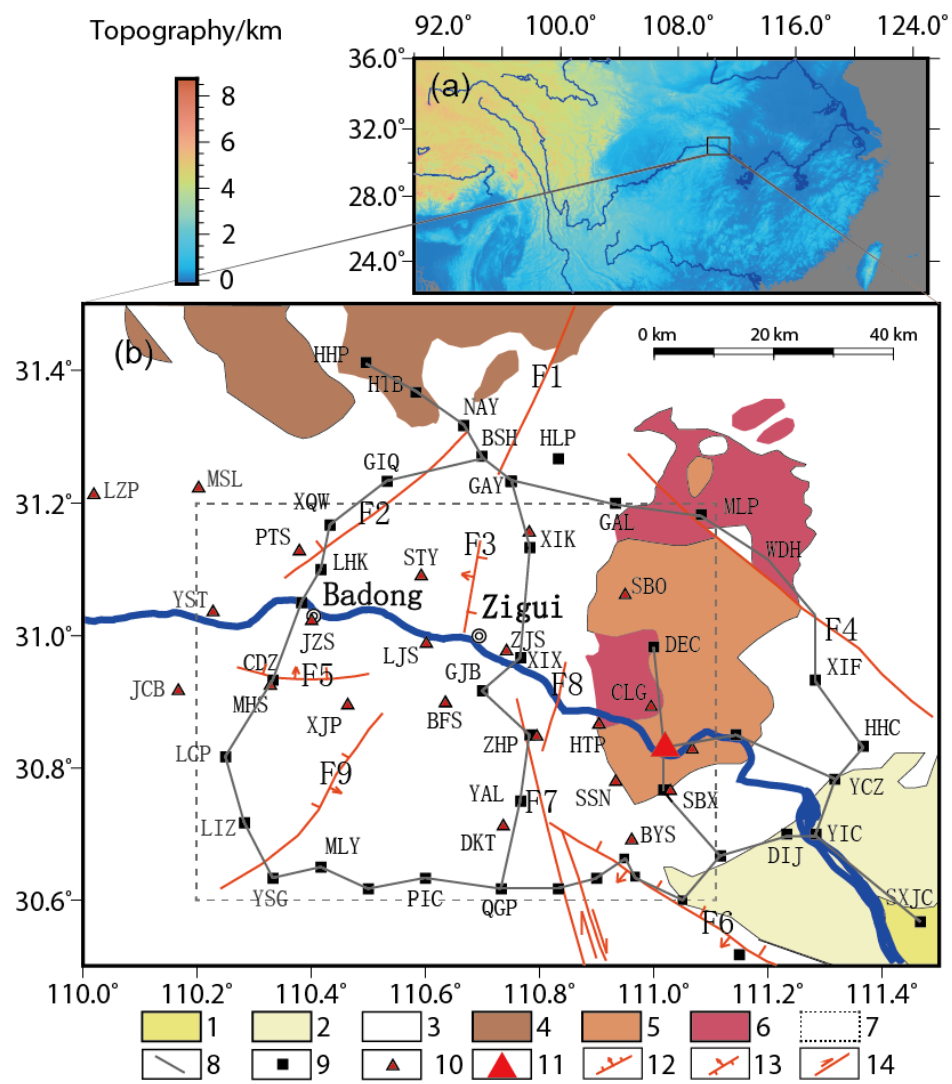
Figure 1. Comprehensive information of the head area of the TGR. ( a ) The location of the study area; ( b ) overview of the geological structure in the head area of the TGR and the reservoir-induced earth- quake monitoring system for the Yangtze River Three Gorges Project. (1. Quaternary strata; 2. Cre- taceous~Upper Triassic upper caprock structural sublayer; 3. Sinian~Middle Triassic lower caprock structural sublayer; 4. Middle Proterozoic-upper basement structural sublayer; 5. Lower Protero- zoic-lower basement structural sublayer; 6. Jingningian period intermediate-acid igneous rocks; 7. The Three Gorges key monitoring area; 8. Gravity Survey Line; 9. Gravity observation network; 10. Seismic stations; 11. The Three Gorges Dam; 12. Normal fault; 13. Reverse fault; 14. Strike–slip fault. Faults: F1, Xinhua faults; F2, Gaoqiao faults; F3, Shuitianba faults; F4 Wuduhe, faults; F5,